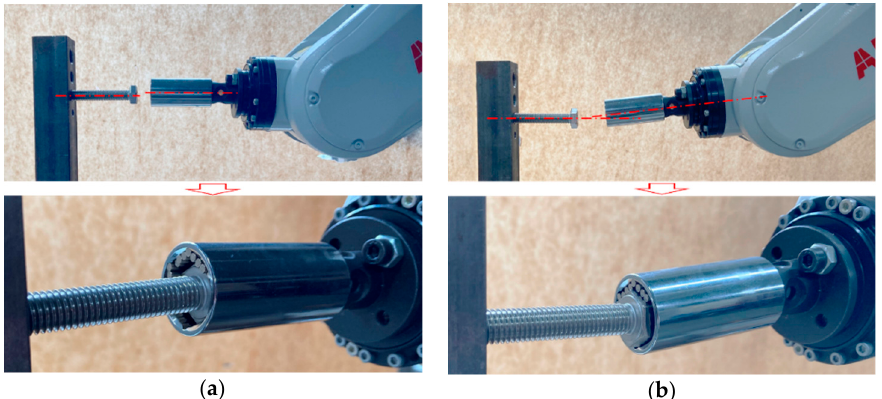
Figure 25. Docking experiment of traditional universal wrench and bolt. ( a ) The docking condition with radial deviation. ( b ) The docking condition with angle deviation.